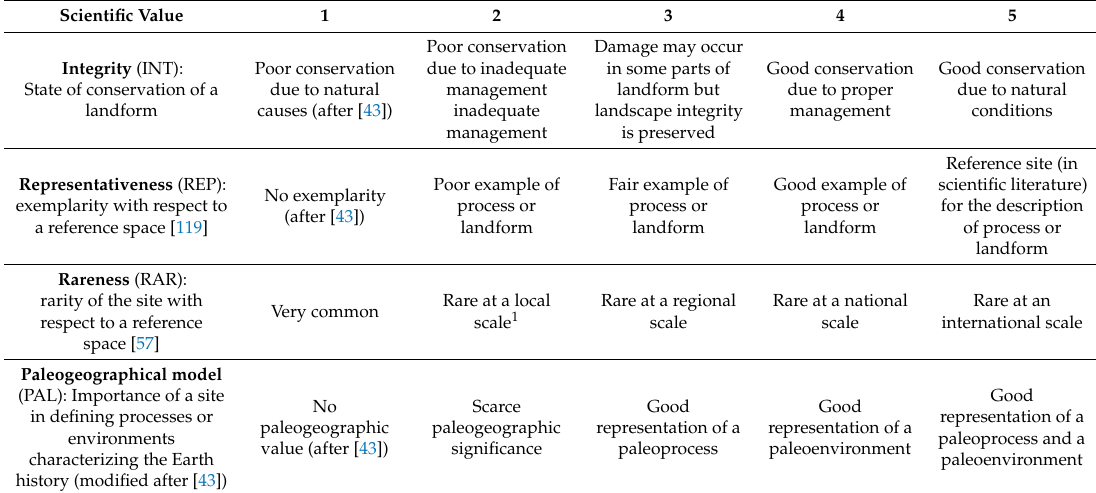
Table 3. Sub-criteria used for the numerical assessment of geosite scientific value.